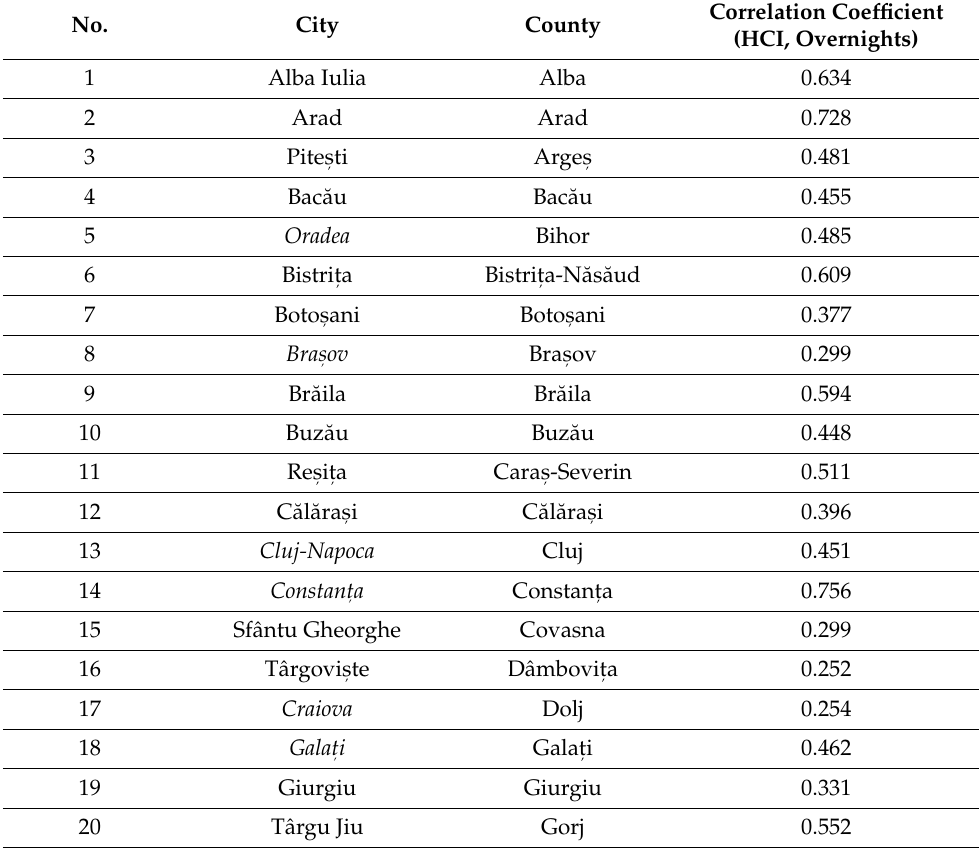
Table 2. The correlation coefficient between the monthly mean HCI and monthly mean number of overnight tourists, for 2010–2018, for urban destinations. No. City County